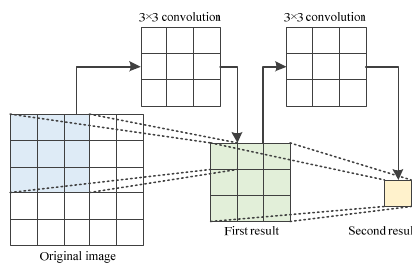
Figure 6. Process of 3 × 3 ordinary convolution twice.